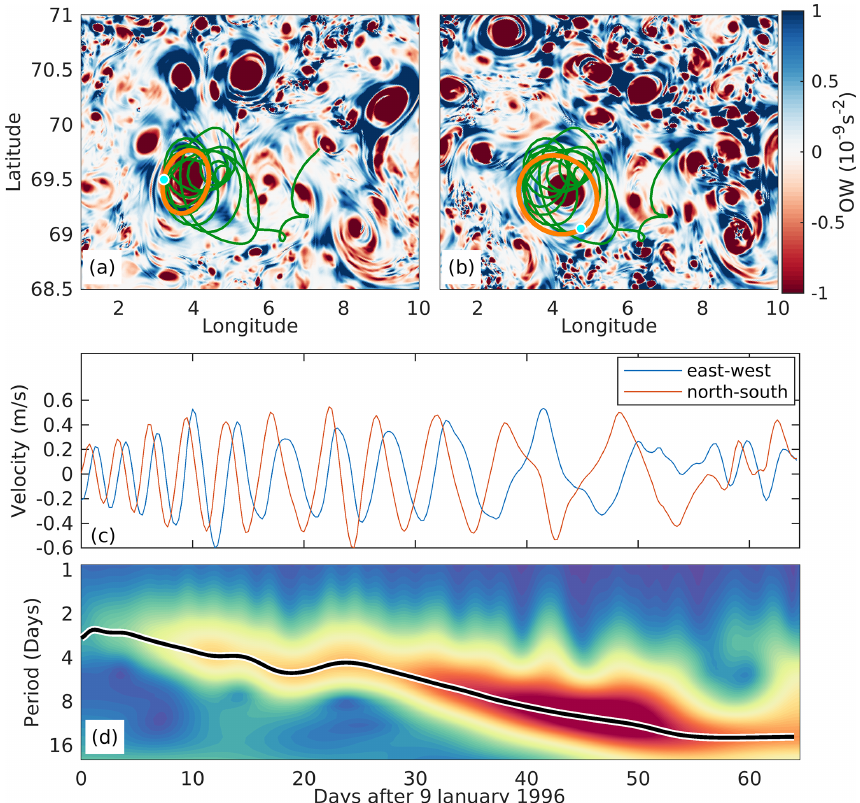
Figure 2. (a, b) The basin trajectory (the ridge segment) from Fig. 1b superimposed on snapshots of the OW field (see text) from (a) 1 February 1996 and (b) 15 February 1996. Cyan dots and orange ellipses show the position of the drifter and the instantaneous spanned-out ellipse (see text) as computed from the MWRA routine at the two dates. Color bar unit is 10 − 9 s − 2 . Example of the MWRA routine applied to the trajectory is shown in (c, d) . (c) The east–west and north–south velocities ( u and v ) of the trajectory. (d) The magnitude of the total (cid:112) | w + (t,s) | 2 +| w − (t,s) | 2 , where | w + (t,s) | and | w − (t,s) | are the absolute values of the positive and wavelet transform || w z ,ψ (t,s) || = negative rotary transforms, respectively. The black line indicates the ridge which is given by the maximum of || w z ,ψ (t,s) ||